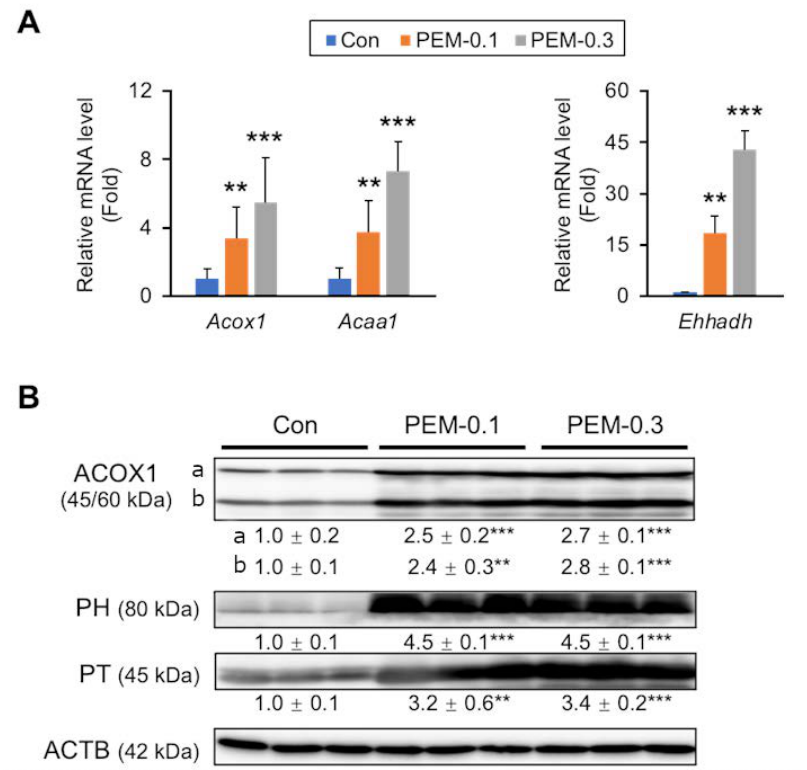
Figure 5. PEM augments peroxisomal FA β -oxidation. ( A ) Hepatic mRNA levels of genes related to peroxisome FA β -oxidation ( Acox1 , Acaa1 , and Ehhadh ) were quantified by qPCR, normalized to that of 18s ribosomal RNA, and expressed as values relative to those of control mice. ( B ) Immunoblot analysis of ACOX1, PH, and PT. ACTB was used as a loading control. Band intensity was measured densitometrically, normalized to that of ACTB, and expressed as values relative to those of control mice. Results were obtained from two independent immunoblot experiments. Data are expressed as the mean ± SD. ** p < 0.01 and *** p < 0.001 vs. control group. Con, vehicle-treated mice; PEM-0.1, pemafibrate-treated mice at a clinically relevant dose (0.1 mg/kg/day); PEM-0.3, pemafibrate-treated mice at a relatively high dose (0.3